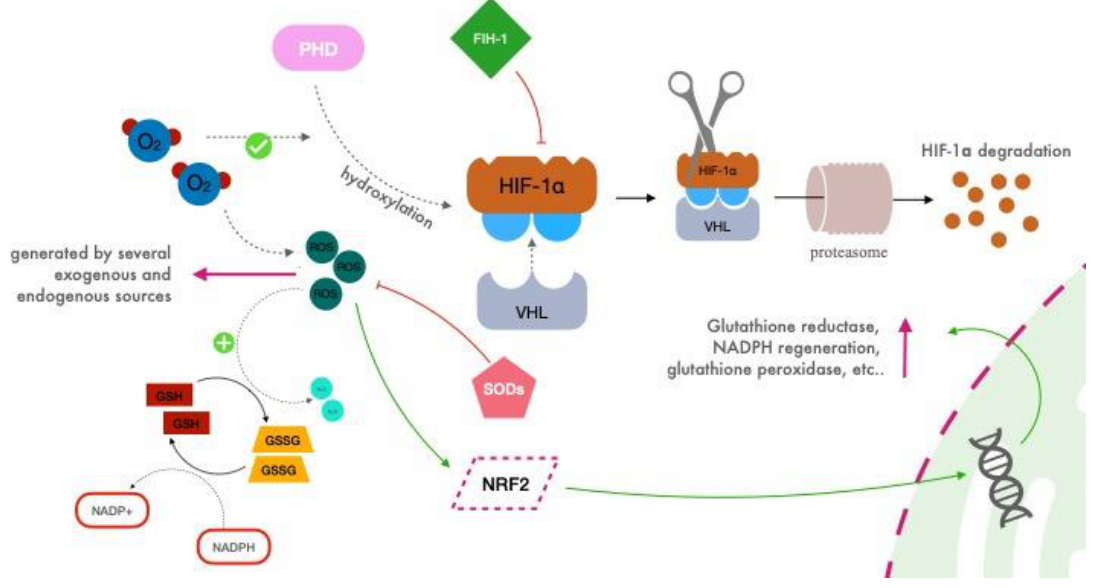
Figure 1. Simplified schematic representation of HIF activity during normoxia.